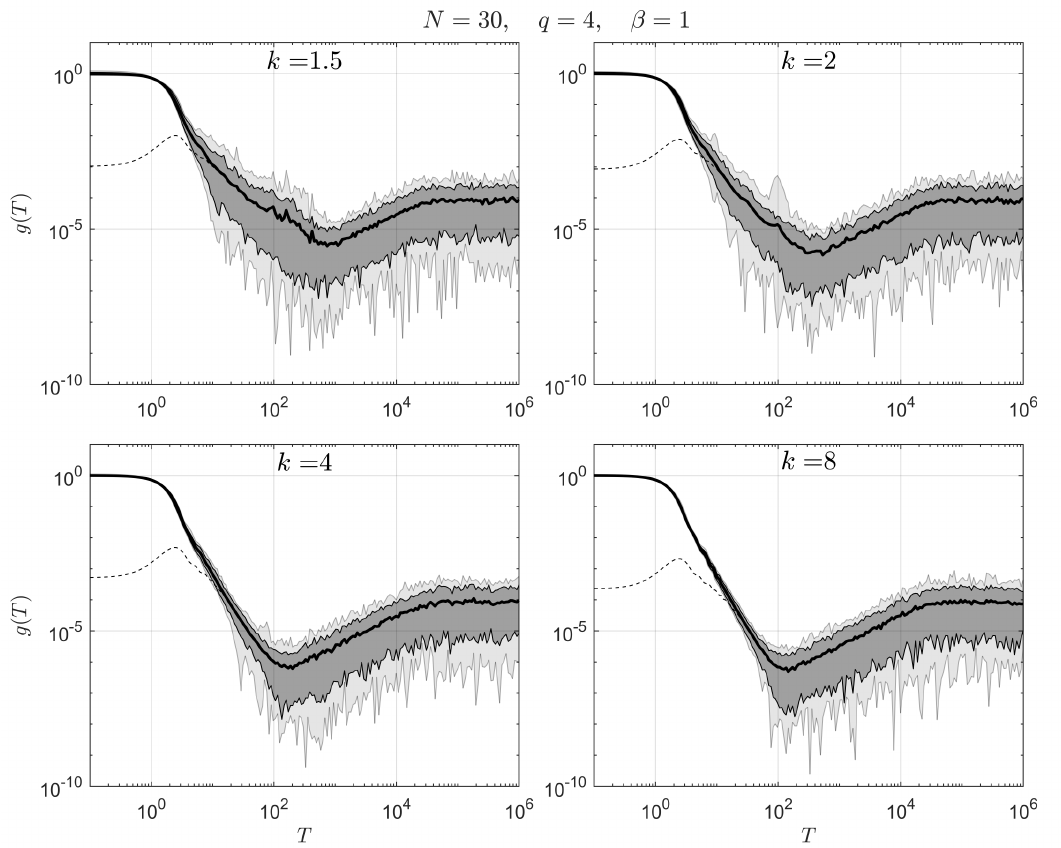
Figure 7 . The spread of the spectral form factor over the 100 disorder realizations of the random couplings. The black line is the disorder averaged spectral form factor, the light gray area is the maximal spread of the SFFs, while the dark gray area contains 90% of the disorder realizations. The disconnected part of the SFF is plotted in a dashed line to give some indication of time